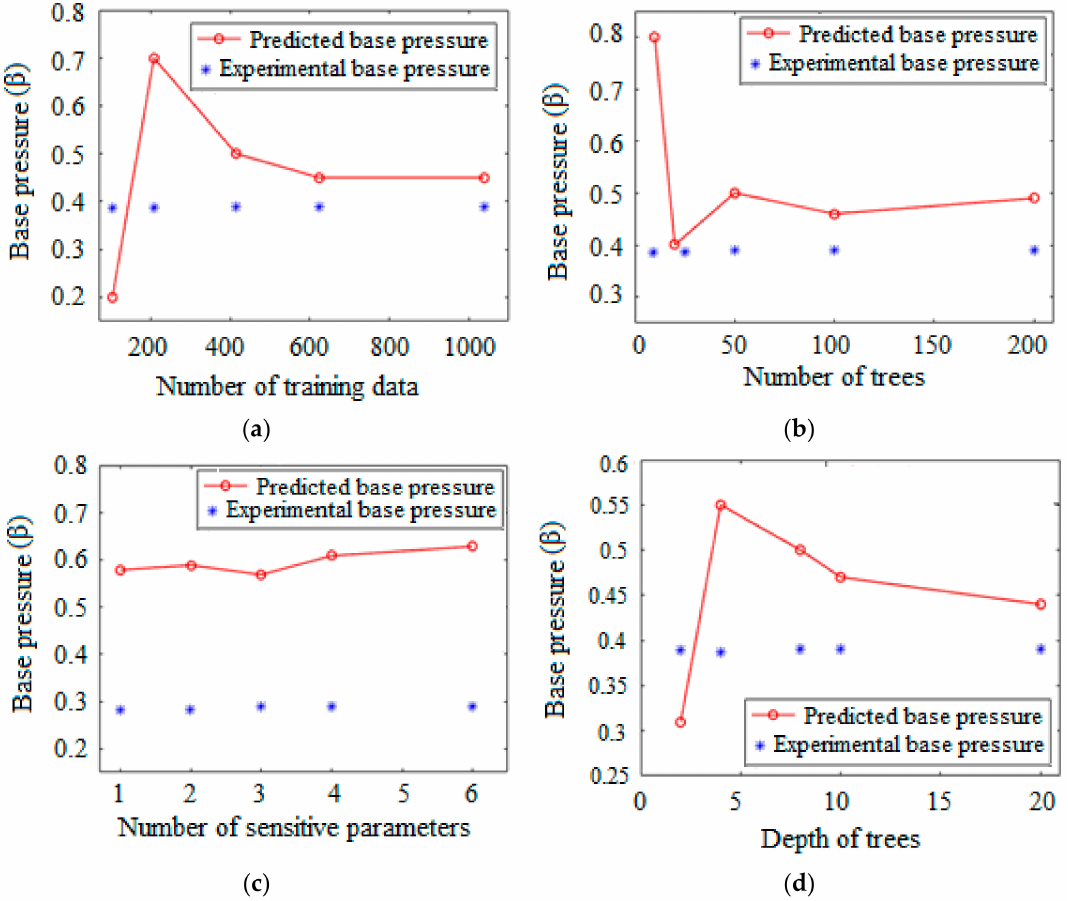
Figure 13. Variations in predicted base pressure ( β ) for different variables of the RF model: ( a ) Predicted ( β ) versus ´ n data , ( b ) predicted ( β ) versus ´ n tree , ( c ) predicted ( β ) versus ´ n var , and ( d ) predicted ( β ) versus ´ n dep